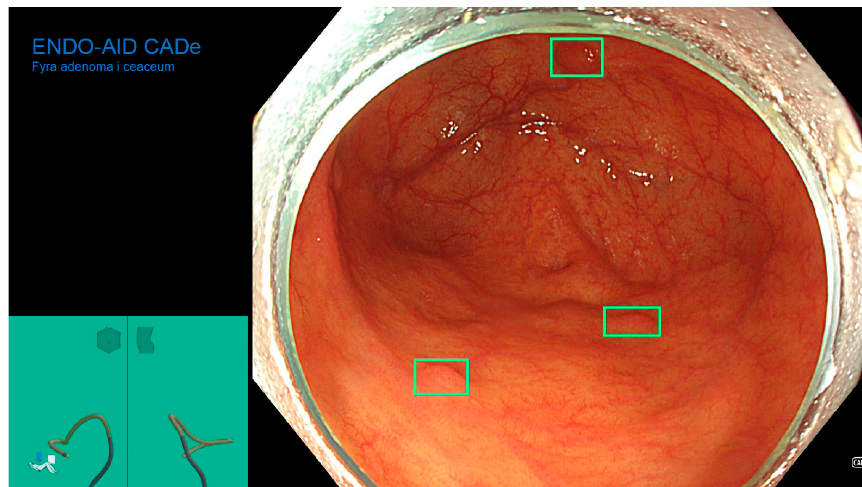
Figure 3. Three polyps detected by CADe AI .